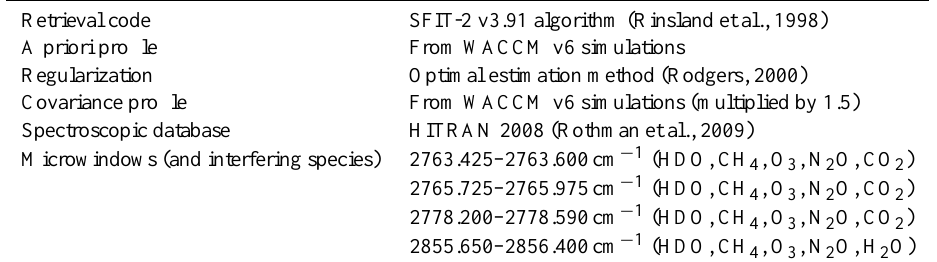
Table 1. Summary of the retrieval strategy for HCHO applied in this study above Jungfraujoch. A thorough description is given by Franco et al.